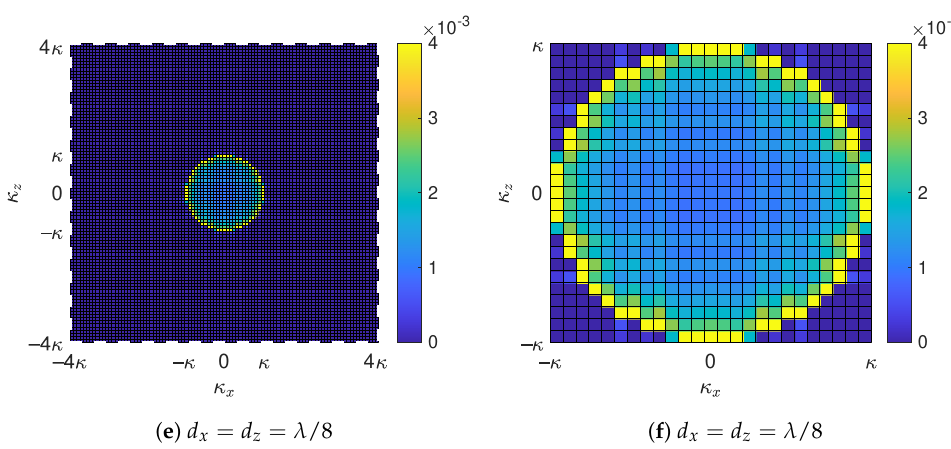
Figure 5. Overview ( a , c , e ) and zoom-in views ( b , d , f ) of the Fourier transform G ( κ x , κ z ) in (23) of the truncated and discretized spatial correlation function g ( ∆ x , ∆ z ) in (18). The colorbars represent the values of G ( κ x , κ z ) , and the white dashed frames in ( a , c , e ) outline the regions within which the wavenumbers are resolvable for the corresponding holographic RIS. Note that κ x and κ z are expressed in terms of the wavenumber κ which is directly labeled on the abscissa and ordinate in each